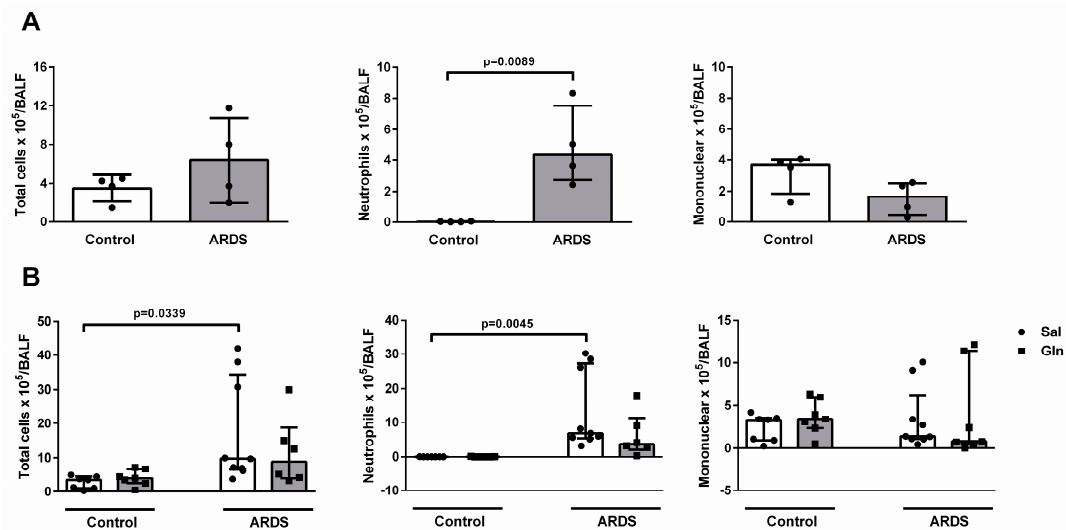
Figure 1. Effects of glutamine on leukocyte recruitment in bronchoalveolar lavage fluid (BALF) in a mouse model of pulmonary ARDS. ( A ) BALB/c mice were randomly allocated to control or acute respiratory distress syndrome (ARDS) groups. In ARDS, mice received E. coli LPS intratracheally (10 µg/0.05 mL saline), while control animals did not undergo any surgical procedures, instillations, or injections. Six hours after LPS administration, animals in the control and ARDS groups ( n = 4/each) were sacrificed for leukocyte enumeration and differential cell counts in BALF. ( B ) In another group of control and ARDS animals, mice were treated 6 h after LPS instillation with an intravenous dose of saline (170 µL, Sal) or Gln (0.75 g/kg body weight, 170 µL). Twenty-four hours after LPS instillation, Control-Sal, Control-Gln, ARDS-Sal, and ARDS-Gln animals were sacrificed for leukocyte enumeration and differential cell counts in BALF. Values are presented as median (interquartile range). Symbols represent individual animals. Experiments were performed in triplicate. The data shown are from a single representative experiment.